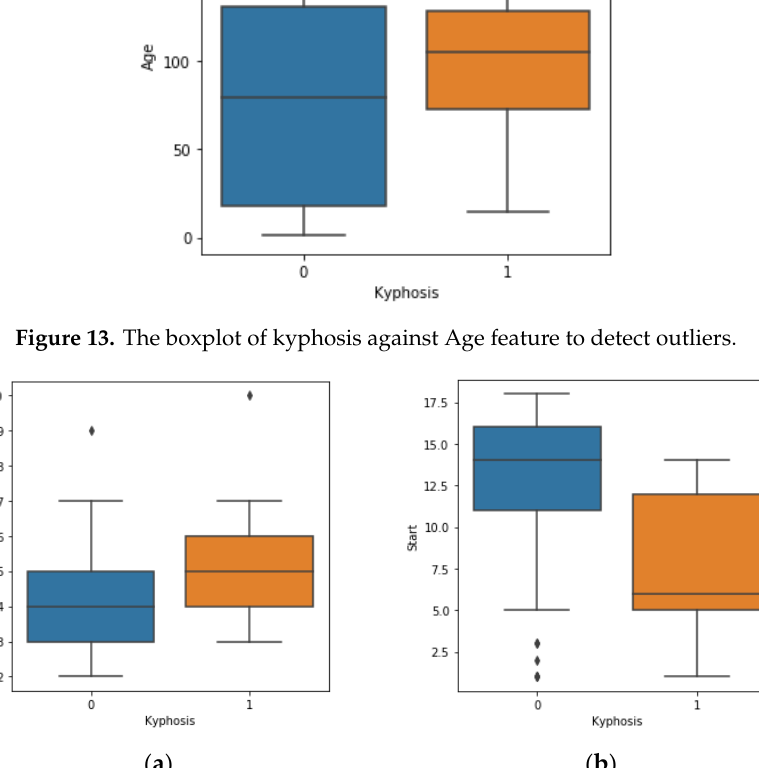
Figure 14. ( a ) The boxplot of kyphosis against Number feature to detect outliers; ( b ) The boxplot of kyphosis against Start feature to detect outliers.